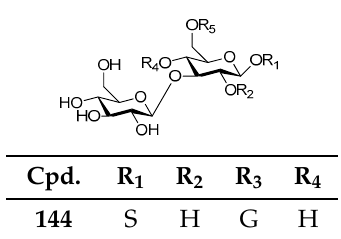
Figure 10. Structures of compounds 142 – 143 .